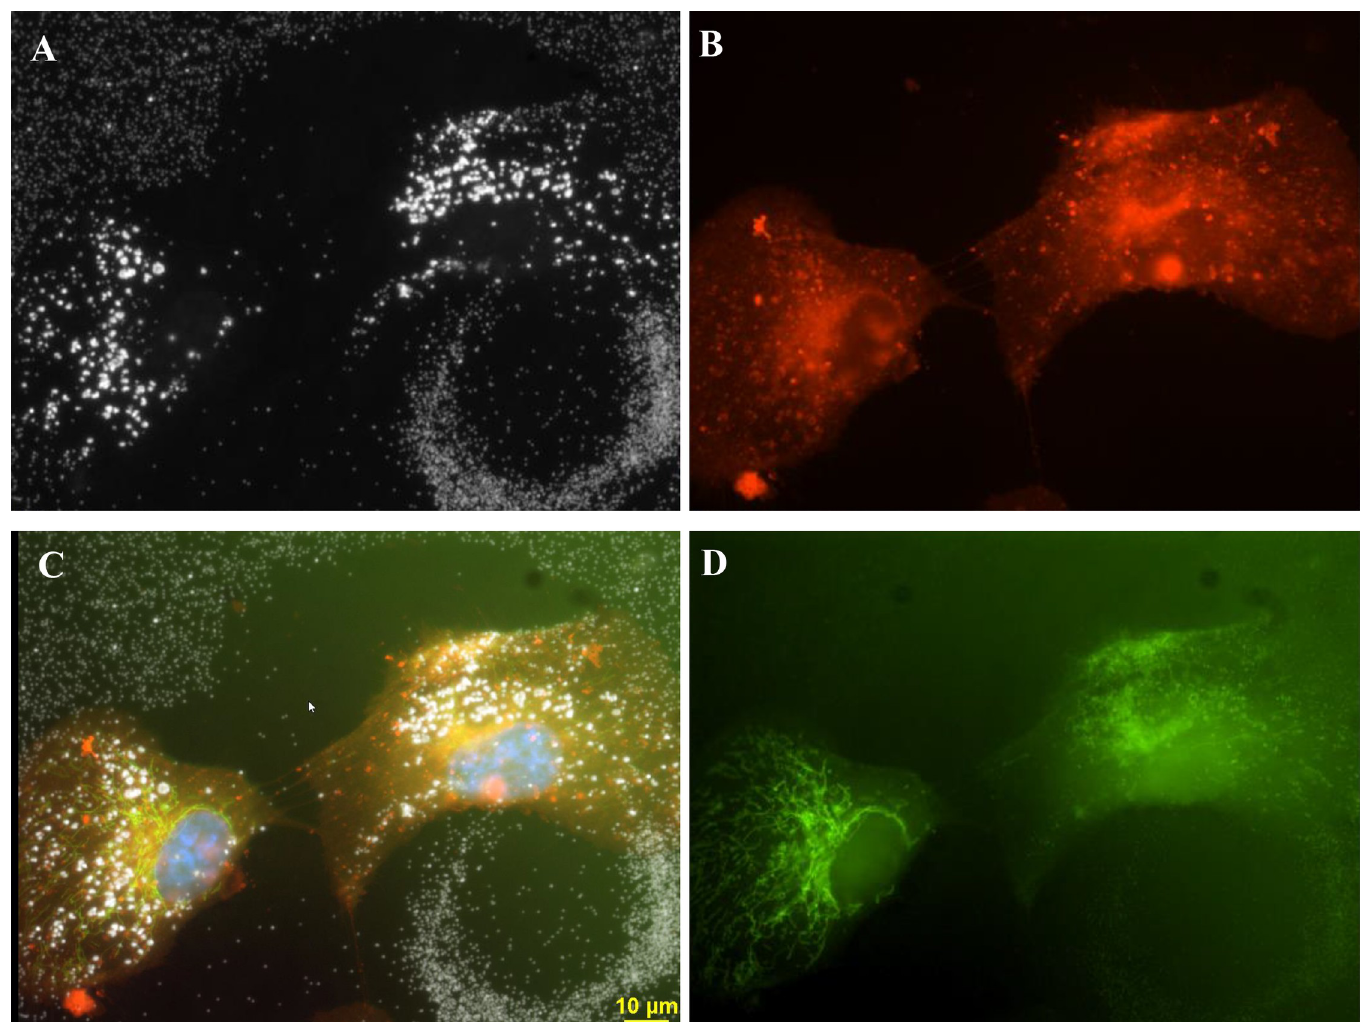
Fig 8. The four-panel figure of cell shown in Fig 2A was treated with 3ug/ml AgNP. The individual dark field and fluorescent images were combined into a composite image (C) Panel A. Darkfield image of a cell with an adjacent ring structure. Panel B. Cell stained with CellMask Orange plasma membrane stain. Panel C. Composite image of fields A, B, and C combined with DAPI stained nuclei (blue). Panel D. Cells transfected with Mito-GFP (green). Magnification